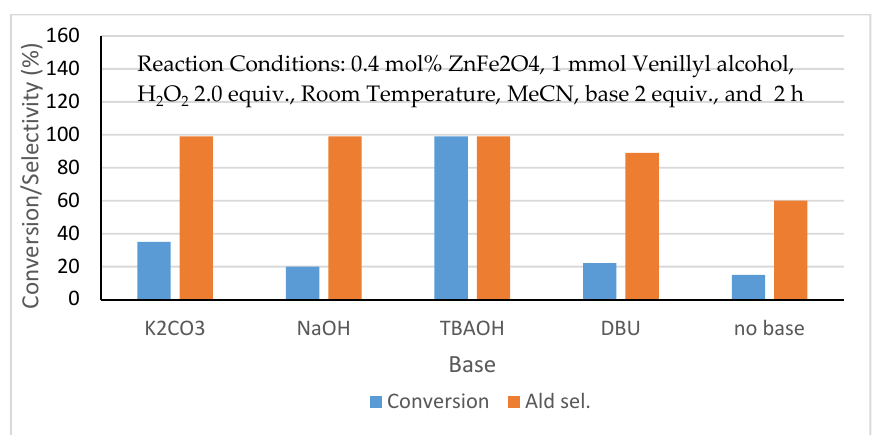
Table 3. Oxidation of other lignin substrate models.